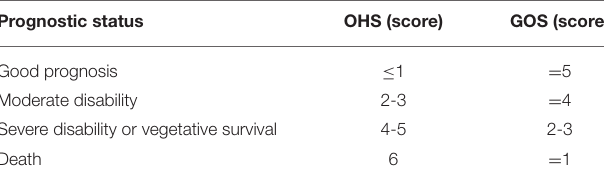
TABLE 2 | The Oxford Handicap Score (OHS) and the Glasgow Outcome Score (GOS) grading standards.